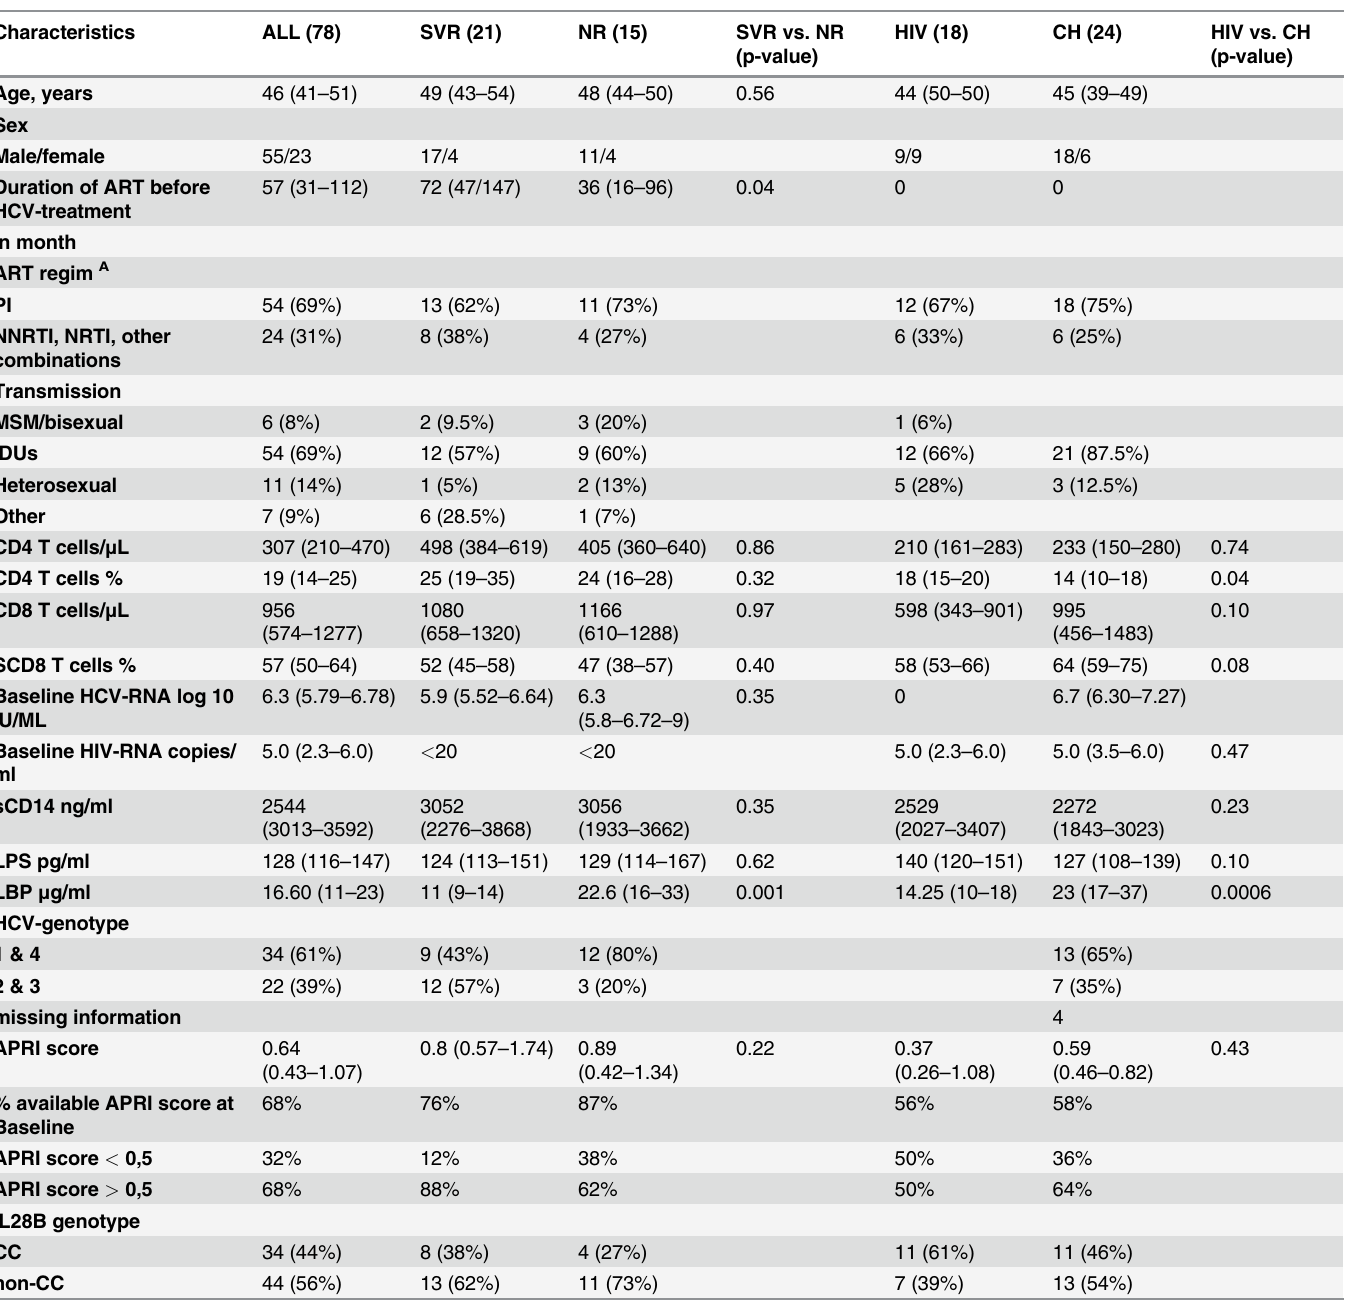
Table 1. Baseline characteristics of study